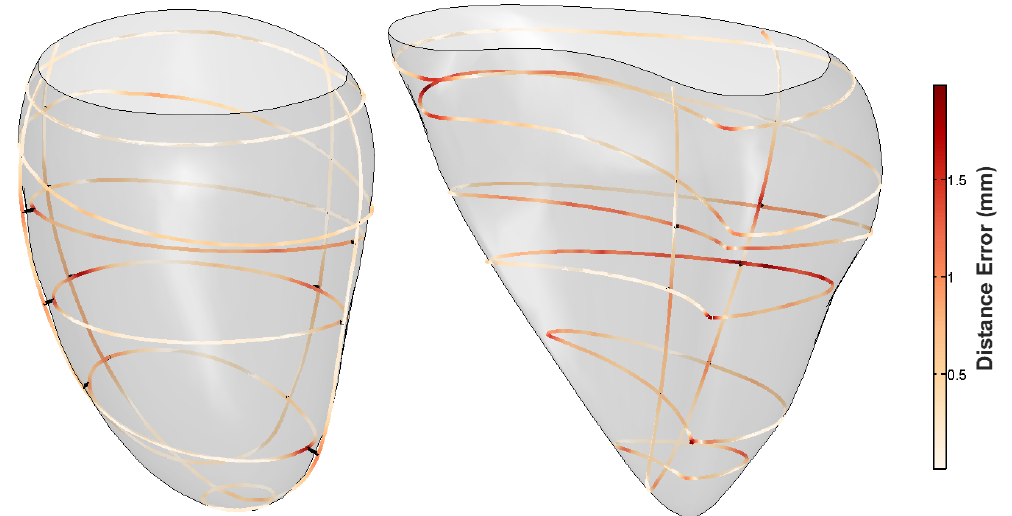
Figure 7. Distance map from the resulting geometrical mesh to the simulated cardiac input data. The contours were transformed by small out of plane rotations and translations. The left panel shows the resulting left ventricular epicardial mesh, and the right panel shows the right ventricular endocardial mesh. The distance errors represent the contour-to-mesh